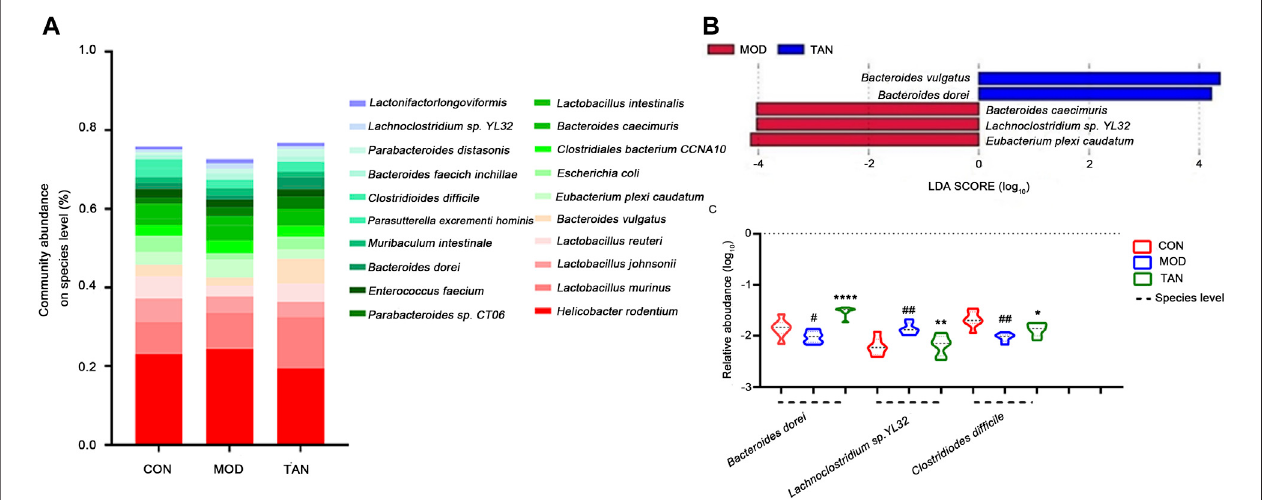
FIGURE6 | TheeffectofTAN on the abundance ofthe gut microbiome at the species level ( n =7rats in each group). (A) The relative abundance ofthe top-ranked species amongthe threegroups. (B) Feature species inthe MOD and TAN groupsat theLDA4 level asanalysed byLEfSe.There wasno feature species detected inthe CONgroupat theLDA4 level. (C) Thecomparisonoftherelative abundance (log10)of Bacteroidetes dorei , Lachnoclostridium sp.YL32,and Clostridiodesdif fi cile inthe three groups. # p < 0.05, ## p < 0.01 vs . CON group and * p < 0.05, ** p < 0.01, **** p < 0.0001 vs . MOD group. Differences were examined by unpaired t test. TAN, tanshinone IIA; CON, control; MOD, model; LDA, linear discriminant analysis.